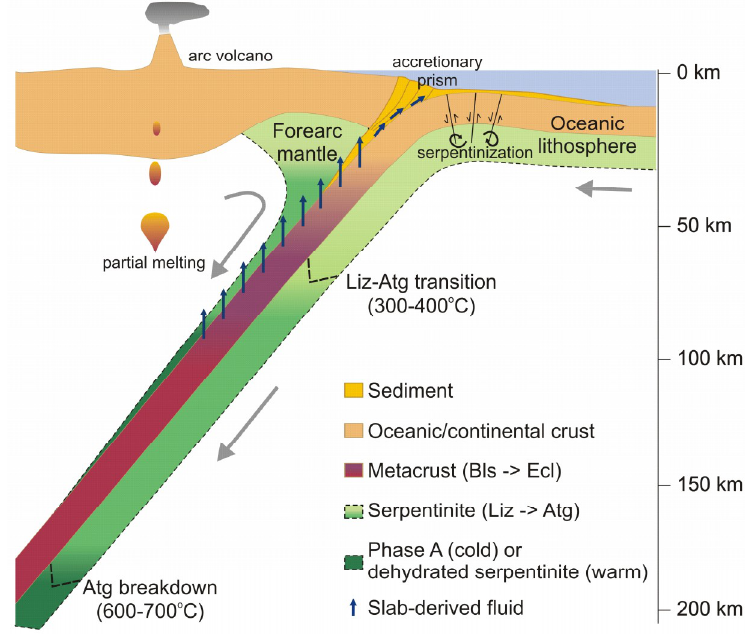
Figure 2. Schematic cross section of a cold subduction zone. Serpentinization of abyssal peridotite occurs on or near the seafloor and along fractures of the bending slab at the outer rise [25,26]. The approximate depths of the lizardite (Liz)–antigorite (Atg) transition [28] and antigorite decomposition [2] are based on a geothermal gradient of ~5 °C/km [29]. In cold subduction zones, fluids and fluid-mobile elements may persist in hydrous phase A after antigorite breakdown [30,31]. Bls: blueschist; Ecl: eclogite.